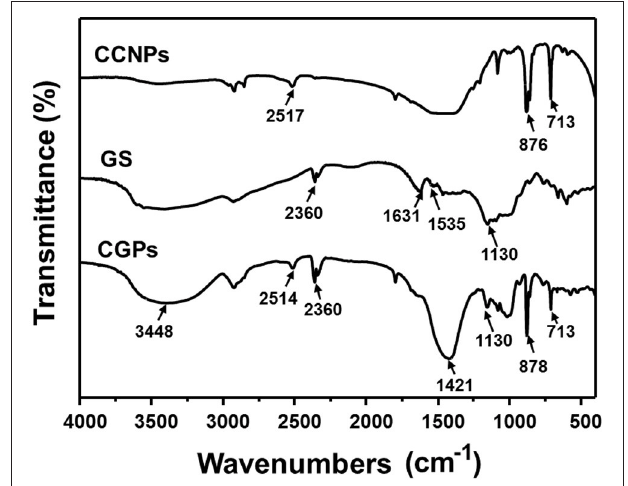
FIGURE 4 | FT-IR spectra of CCNPs, GS, and